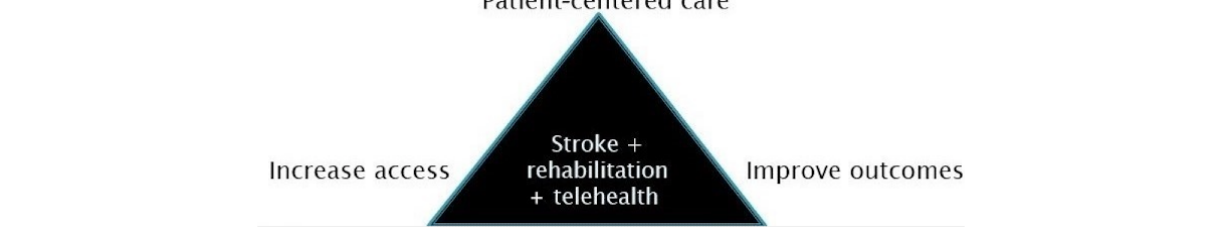
Table 1. Telemedicine services for chronic diseases and telerehabilitation at the Visiting Nurse Association. Stroke rehabilitation and chronic heart